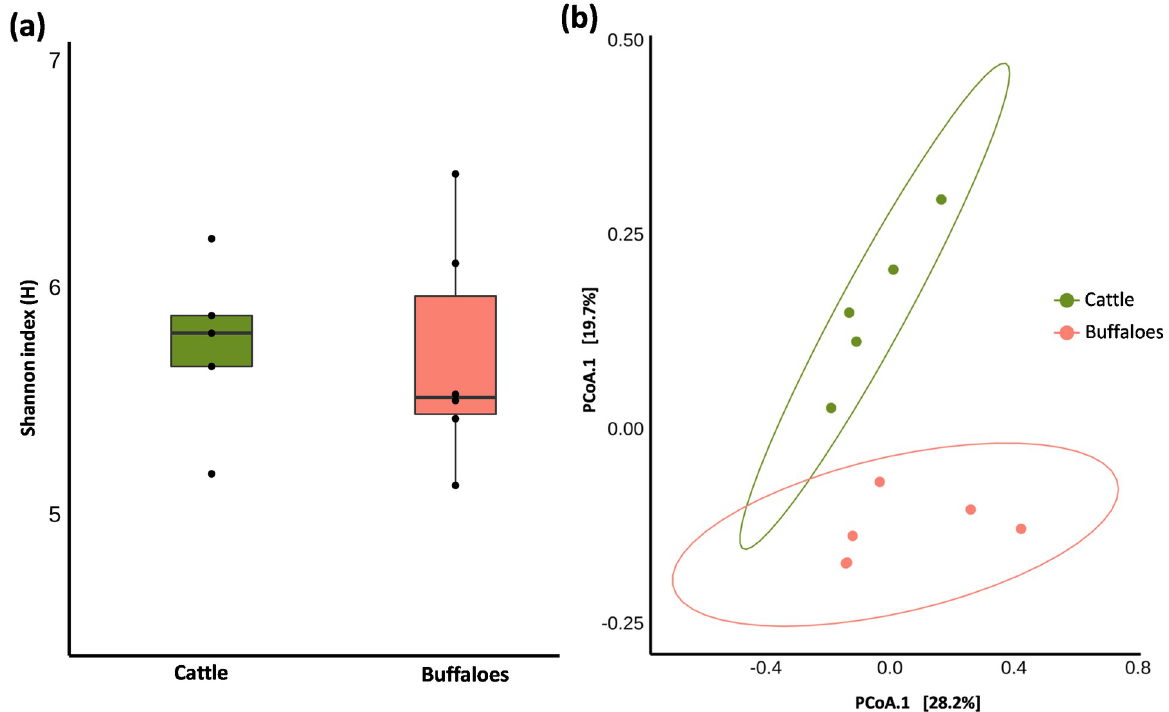
Fig 3. (a) Alpha diversity and (b) Beta diversity of the ruminal methanogens in cattle and buffaloes.